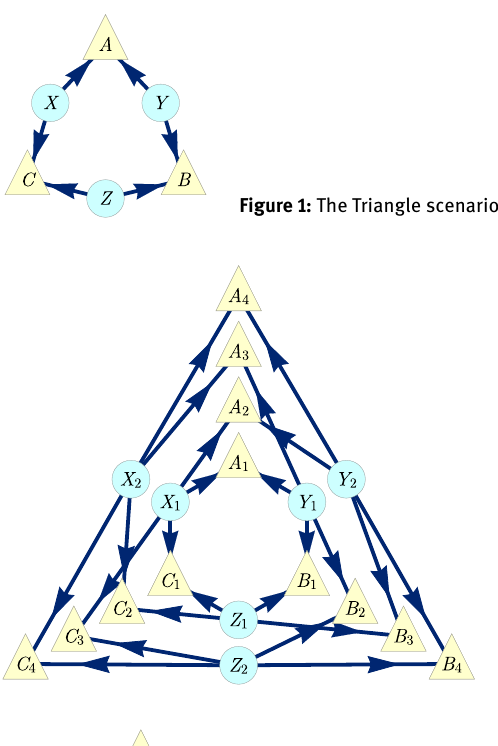
Figure 2: The Web inflation of the Triangle scenario where each la- tent node has been duplicated and each observed node has been quadrupled. The four copies of each observed node correspond to the four possible choices of parentage given the pair of copies of each latent parent of the observed node.